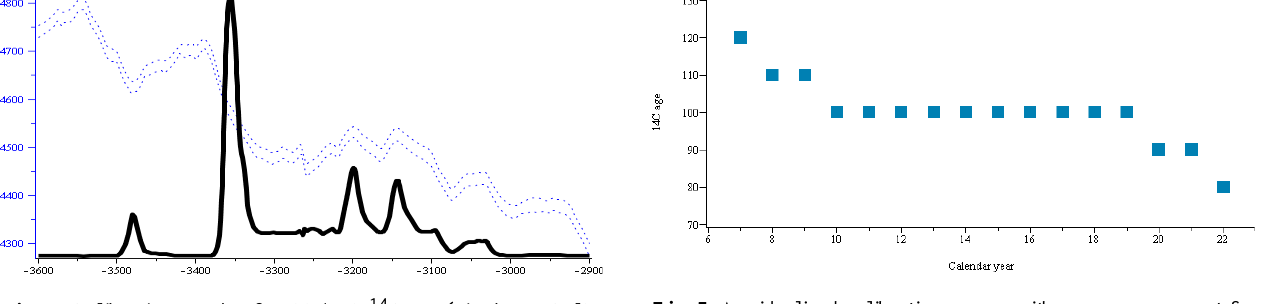
Fig. 4. Calibration graph of 4530 ± 50 14 CBP (via the IntCal04 calibration curve; Reimer et al., 2004), using the discrete method. The result substantively differs from the result illustrated in Fig. 3.